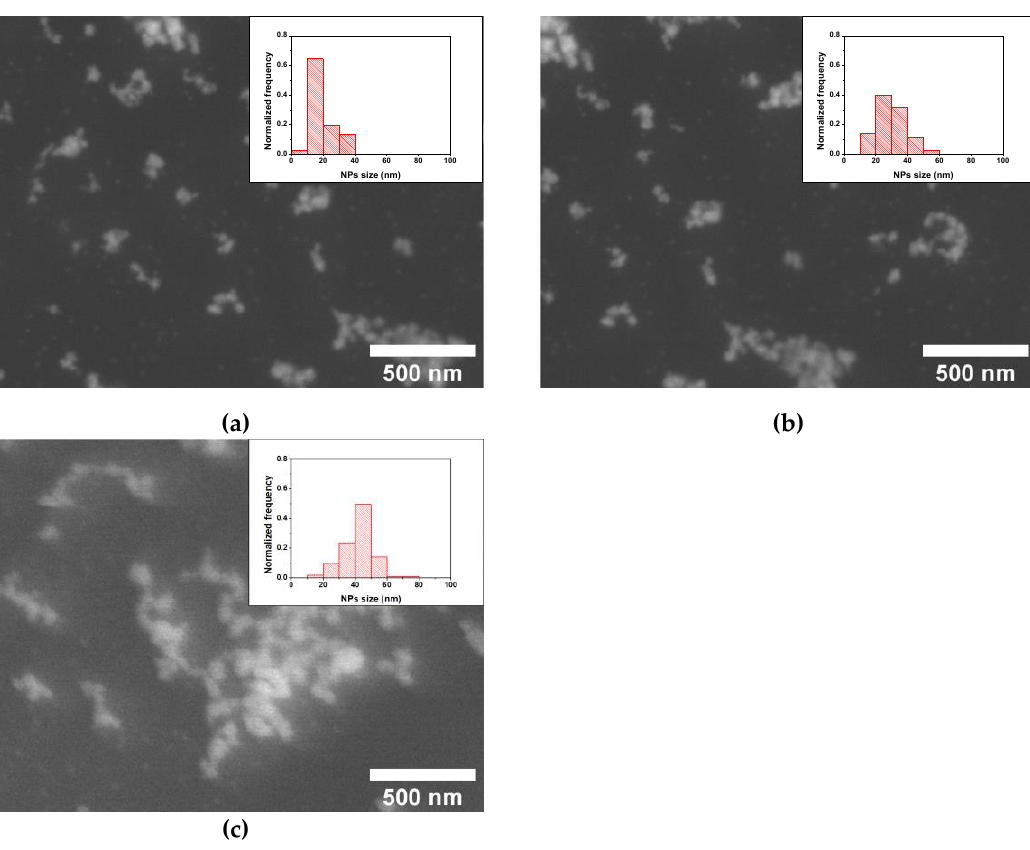
Figure 6. HRSEM micrographs and NPs size distribution (insets) of the obtained ME/PDMS/Pd foams obtained after different reaction times in 0.50 mg/mL of Na 2 PdCl 4 in ethanol: 1 ( a ), 24 ( b ), and 120 h ( c ).